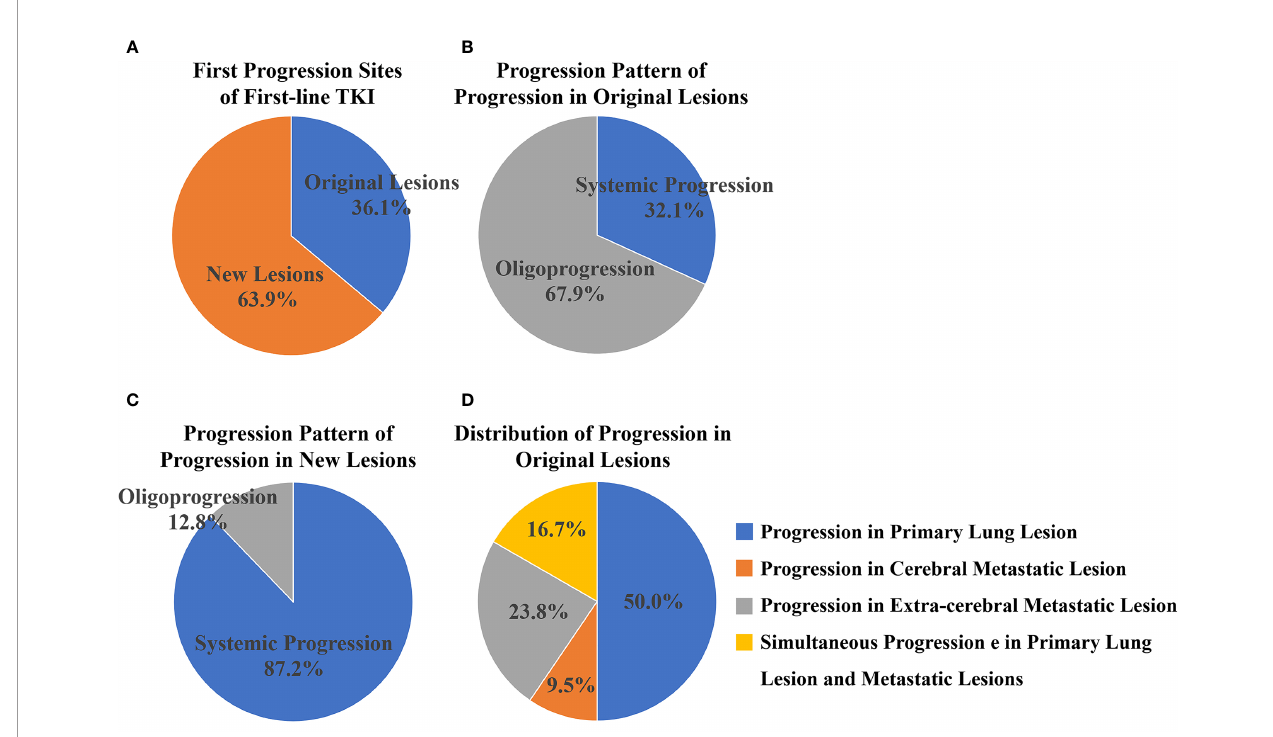
FIGURE 3 | (A) There were 84 (36.1%) and 149 (63.9%) patients developing progression in original lesions and new lesions, respectively. (B) Among patients with progression in original lesions, there were 27 (32.1%) patients with systemic progression and 57 (67.9%) patients with oligoprogression. (C) Among patients with progression in new lesions, there were 130 (87.2%) patients with systemic progression and 19 (12.8%) patients with oligoprogression. (D) For patients with progression in original lesions, there were 42 (50%), 8 (9.5%), 20 (23.8%), and 14 (16.7%) patients developing progression in primary lung lesion, cerebral metastatic lesions, extra-cerebral metastatic lesions, and simultaneous primary lung lesion and metastatic lesions